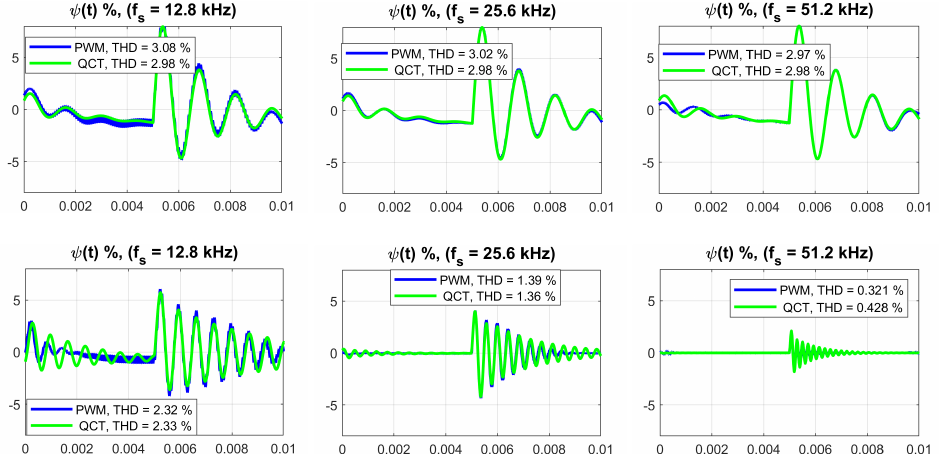
Figure 21. Values of the ψ ( t ) and THD functions obtained from QCT and PWM simulation models. Upper row: uncontrolled system, lower row: PID controlled system. Green lines: QCT simulation, blue lines: PWM simulation.